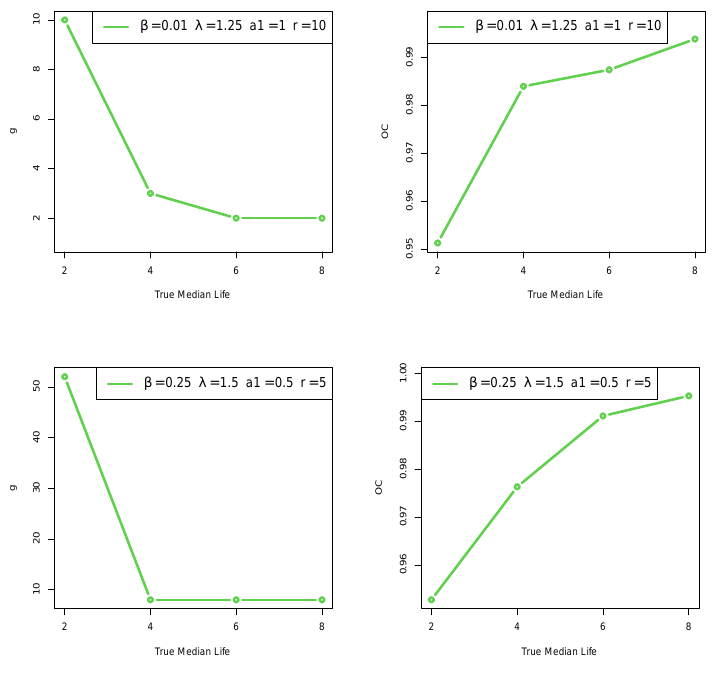
Figure 1. Graphical illustration of g and OC for some parametric values taken from Tables 1 and 2,